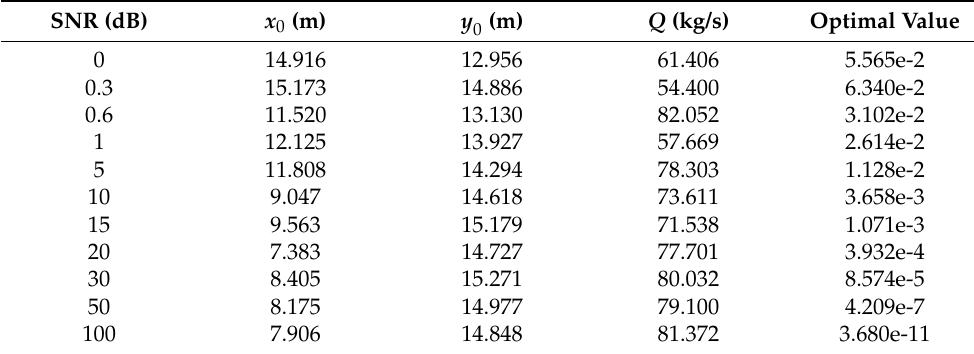
Table 15. The OMO algorithm’s results under different